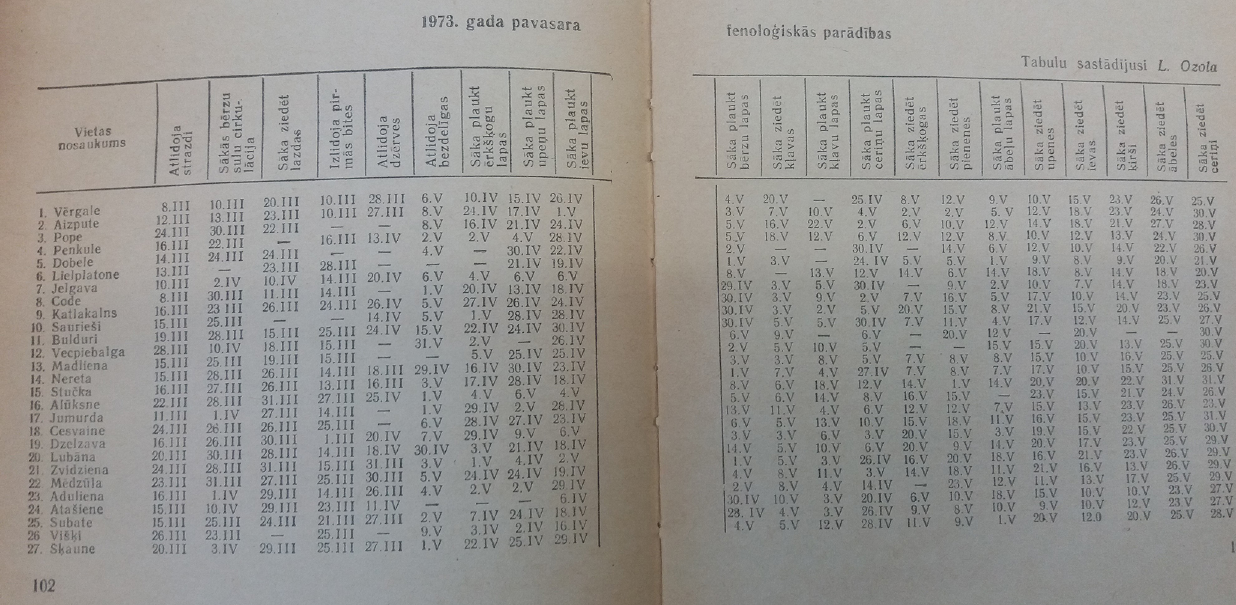
Figure 1. Example of the original paper publication of phenological observations for spring 1973 in the 1974 issue of the Nature and History Calendar yearbook (in Latvian, Dabas un v¯estures kalend¯ars ; “Nature and History Calendar, 1974”, the National Library of Latvia, copyright owner